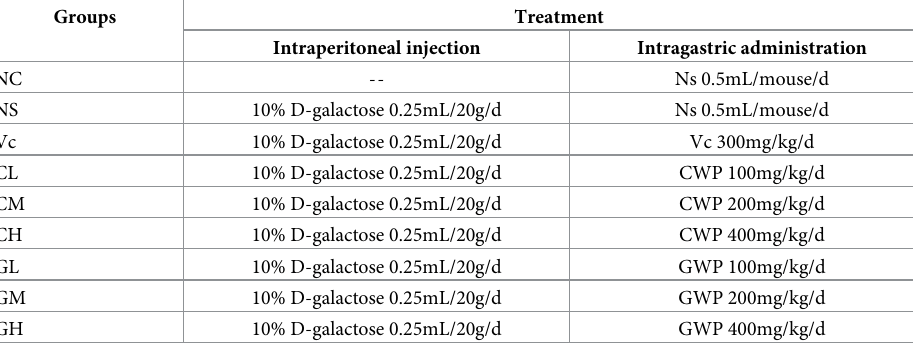
Table 1. Details of different treatment in different